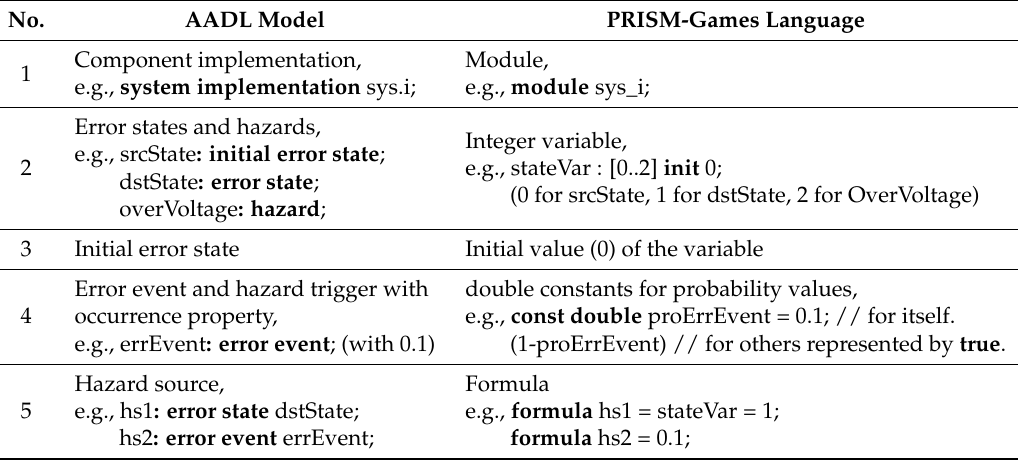
Table 1. Basic rules for the model